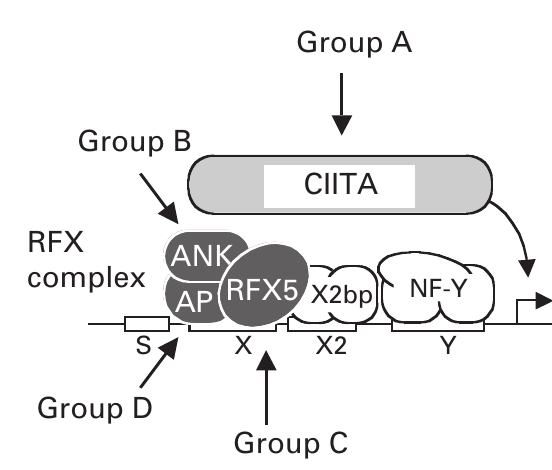
Molecular analysis of patients with MHC-II deficiency has led to the identification of four trans-acting pro- teins essential for MHC-II gene expres- sion. MHC-II pro- moter contains three conserved cis-acting boxes, X, X 2 and Y. The four trans-acting factors mutated in each four